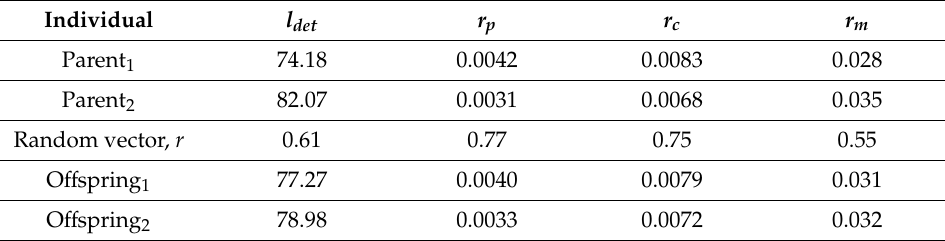
Table 4. Crossover and o ff spring